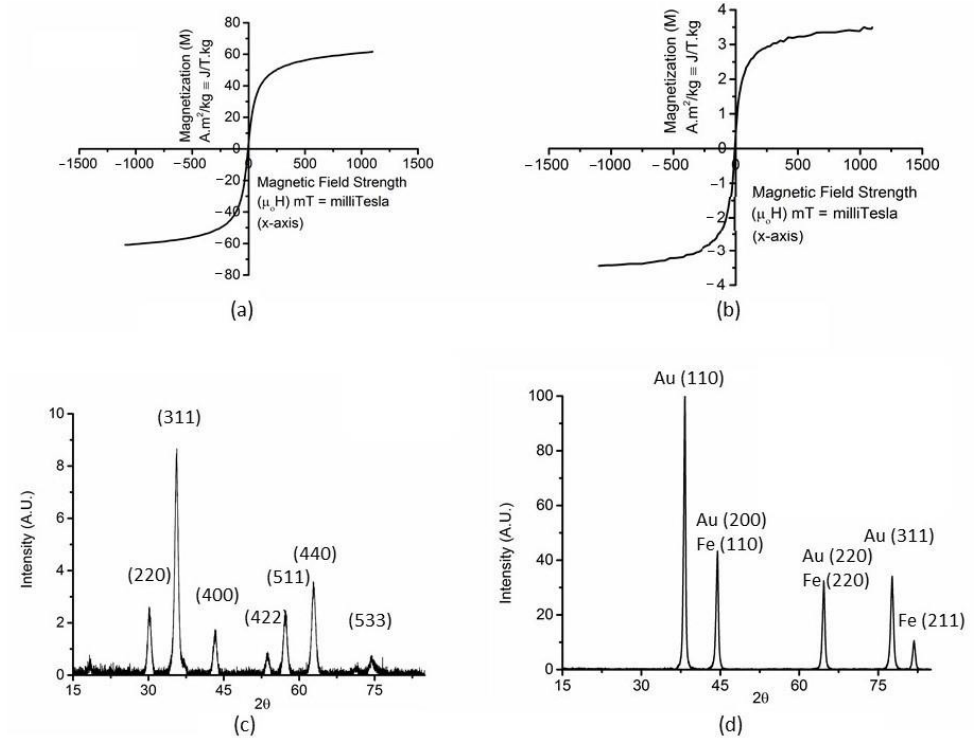
Figure 2. Characterizations of IONPs and ICGNPs: ( a ) VSM, IONPs. ( b ) VSM, ICGNPs. ( c ) XRD, IONPs. ( d ) XRD, ICGNPs.